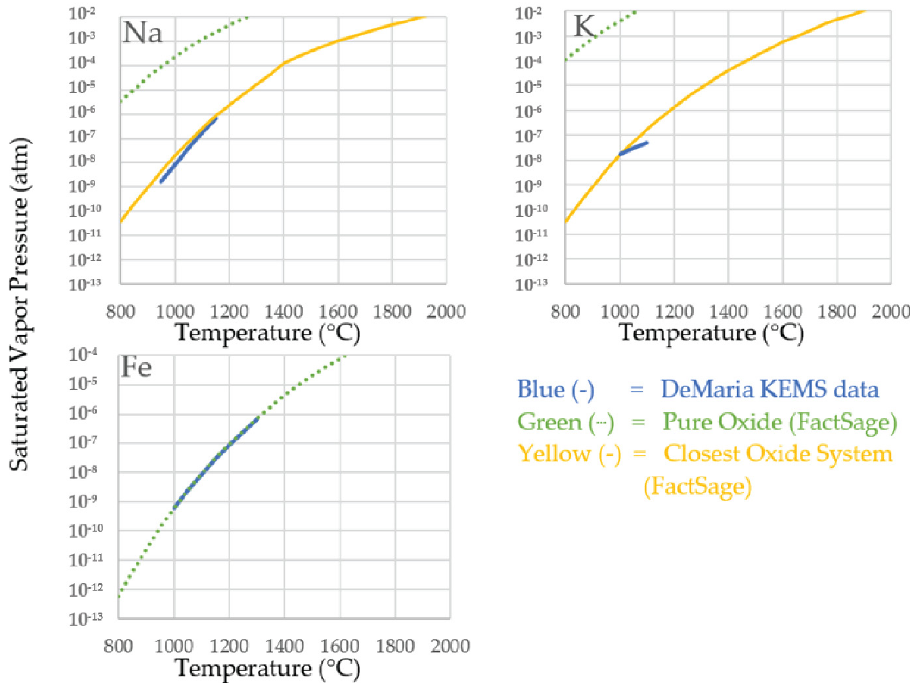
Figure 3. Comparison between measured saturated vapor pressure of species Fe, Na, and K from De Maria et al. [15] shown in blue, and the prediction by FactSage 8.2 software shown in orange, given the Apollo sample #12022 feed shown in Table 1.